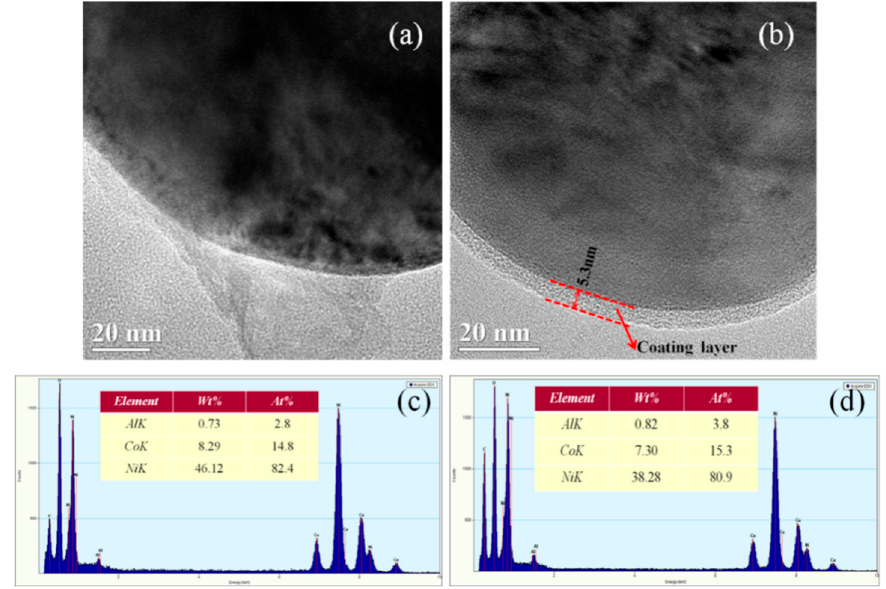
Figure 5. TEM micrographs of the pristine NCA ( a ) and NCA-0.25 ( b ), EDS pattern of the pristine NCA ( c ) and NCA-0.25 ( d ).